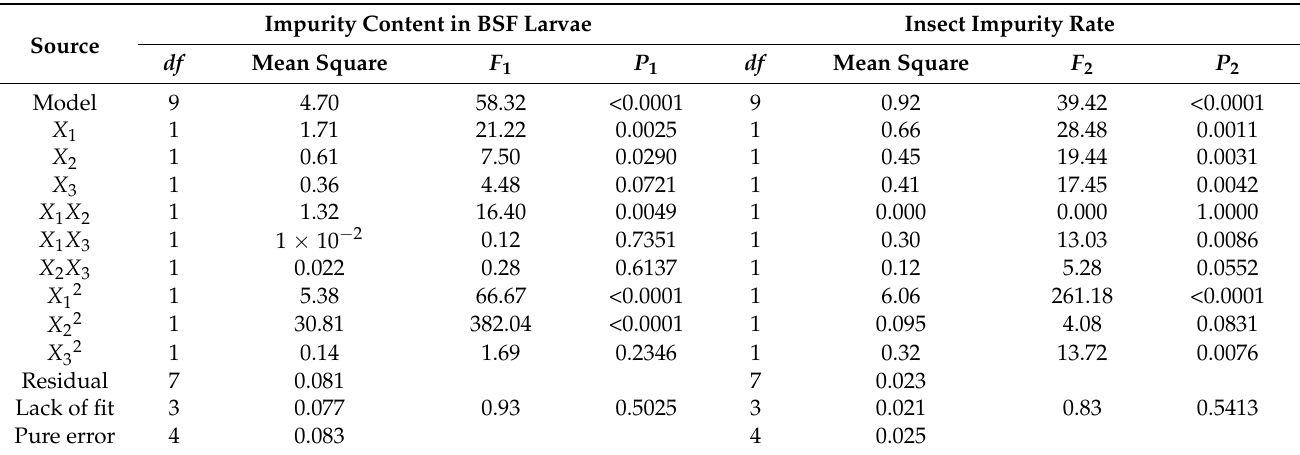
Table 3. Significance test of